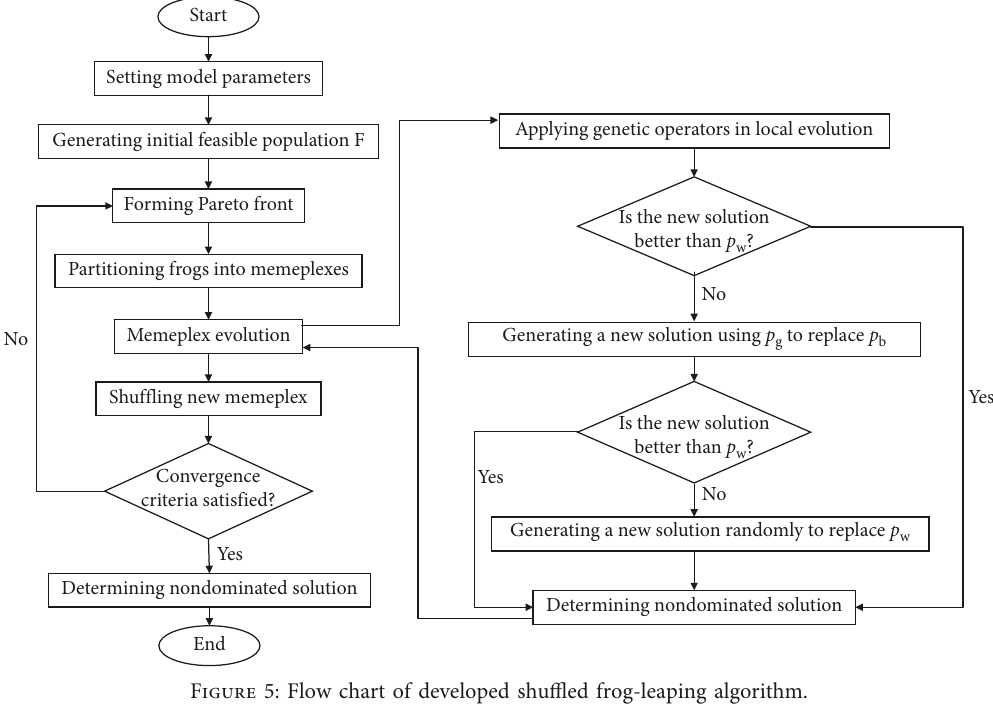
Figure 5: Flow chart of developed shuffled frog-leaping algorithm.